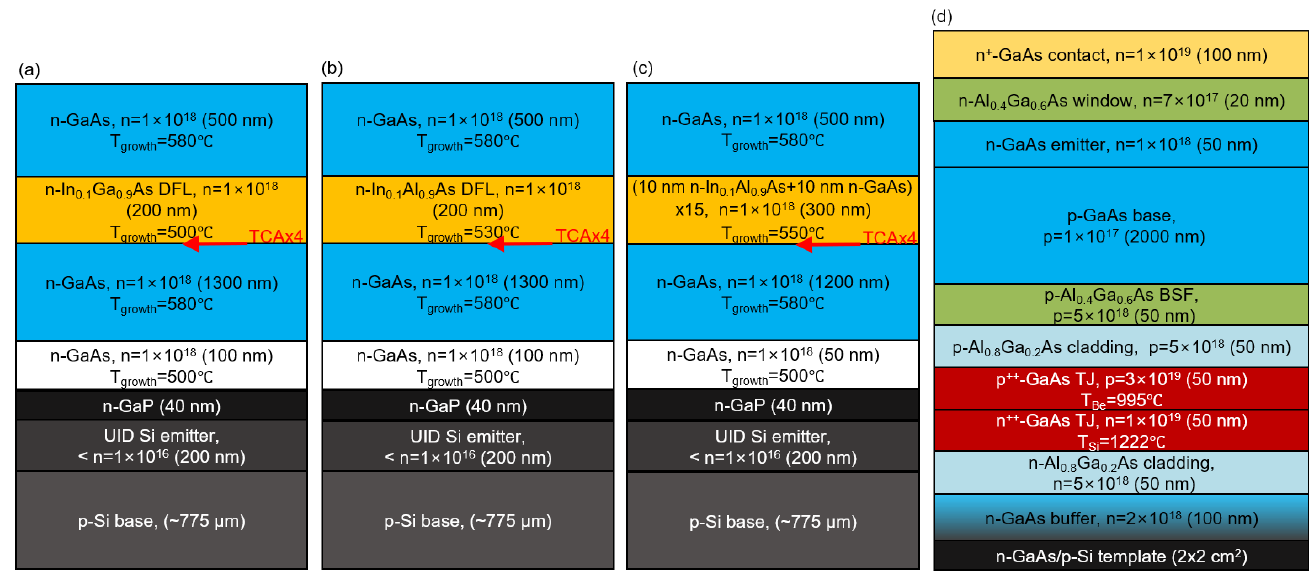
Figure 1. Schematics of the GaAs/Si templates with ( a ) n-In 0.1 Ga 0.9 As DFL, ( b ) n-In 0.1 Al 0.9 As DFL, ( c ) 10 nm n-In 0.1 Al 0.9 As/10 nm n-GaAs SLS, and ( d ) GaAs/Si tandem solar cell.